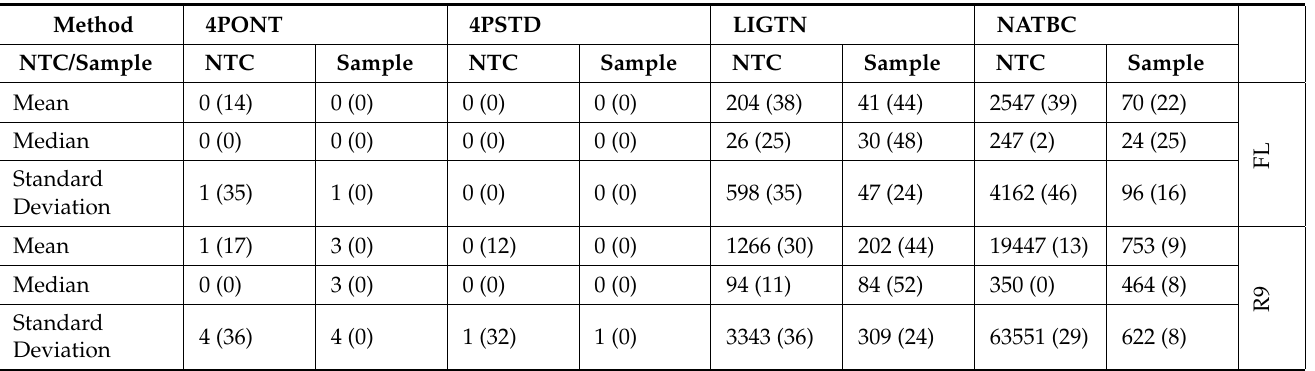
Table 4. FP aligned read statistics. Mean, median, and standard deviation for total (percent) FP aligned reads among samples [group 0] and total (percent) aligned reads among NTC triplicates [group 1] per method and flow cell